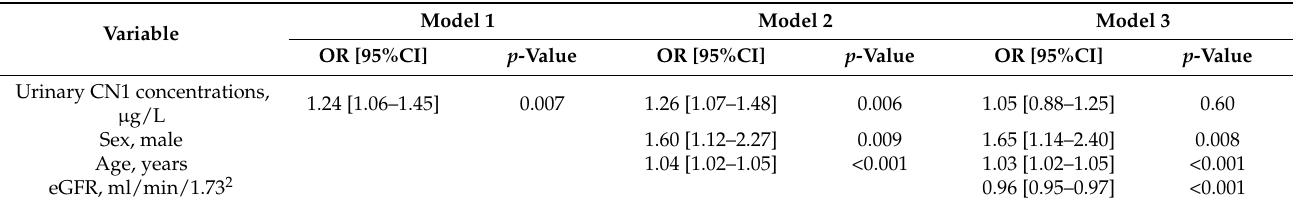
Abbreviations: OR: odds ratio, CI: confidence interval, CN1: carnosinase-1, eGFR: estimated glomerular filtration rate, KTRs: kidney transplant